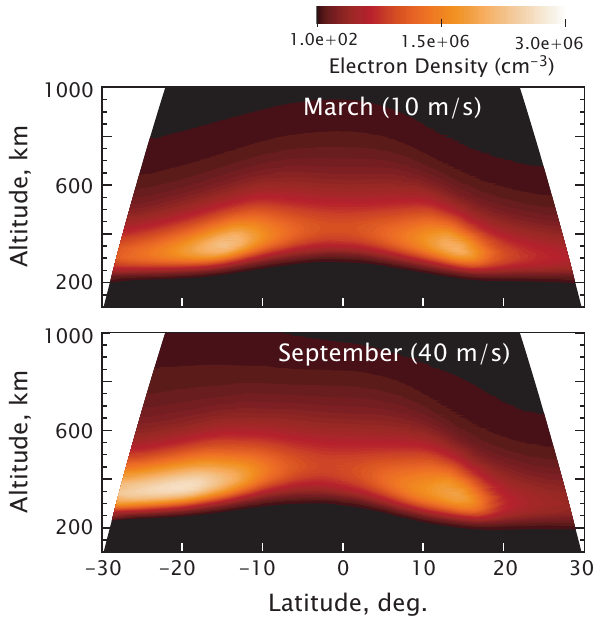
Fig. 5. Contours of electron density plotted in the latitude-altitude plane for the 10-m/s (upper panel) and 40-m/s (lower panel) cases. These show the initial states before ESF develops.